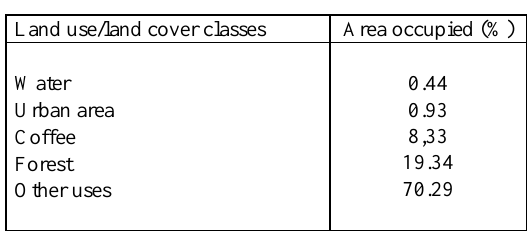
Table 3. Land use/land cover occupation in region of Mantiqueira de